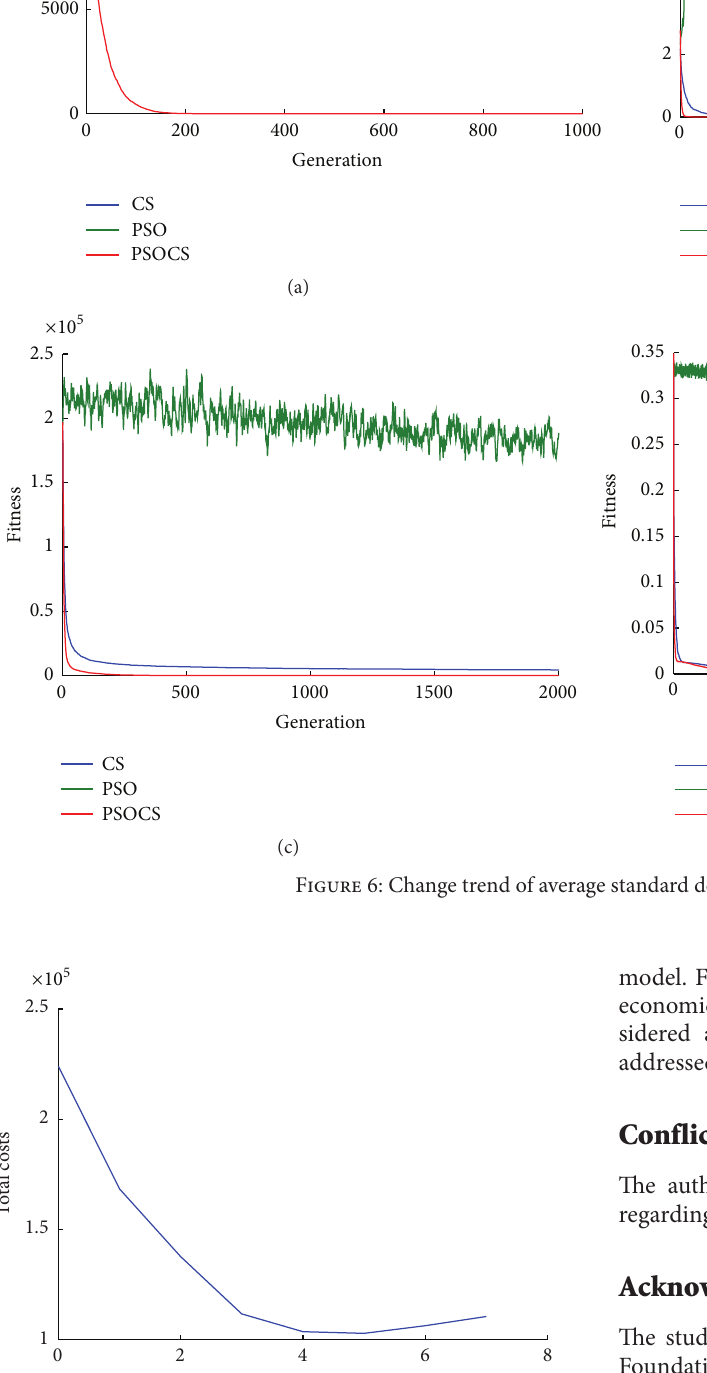
Figure 7: Optimization results of